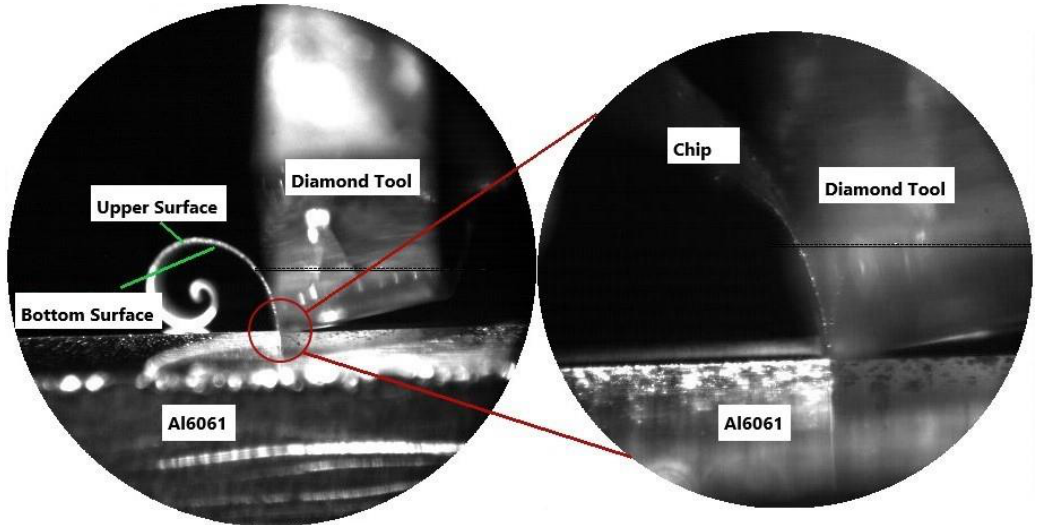
Figure 2. Observation of chip formation in orthogonal diamond cutting of Al6061.